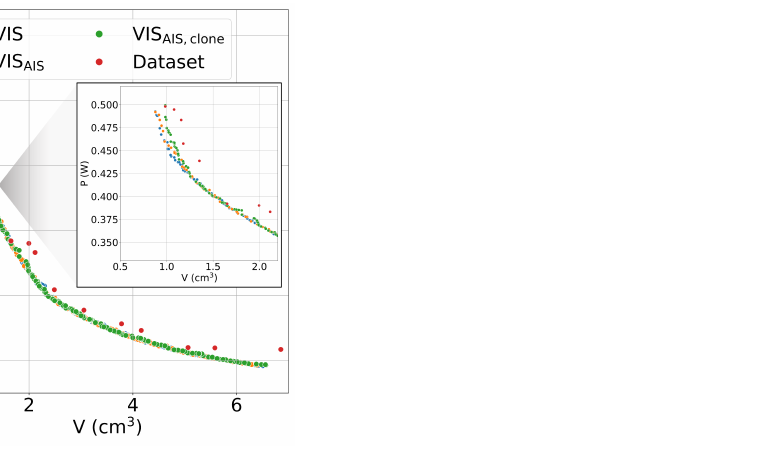
Figure 9. Pareto fronts of the analysed design case, obtained with the three proposed approaches. The reported fronts are computed by combining the solutions of the 30 executions performed in each case. In addition, the Pareto front of the training-test data set is reported. A zoom of the Pareto fronts in the region of small volumes is also reported to highlight the marked differences in this